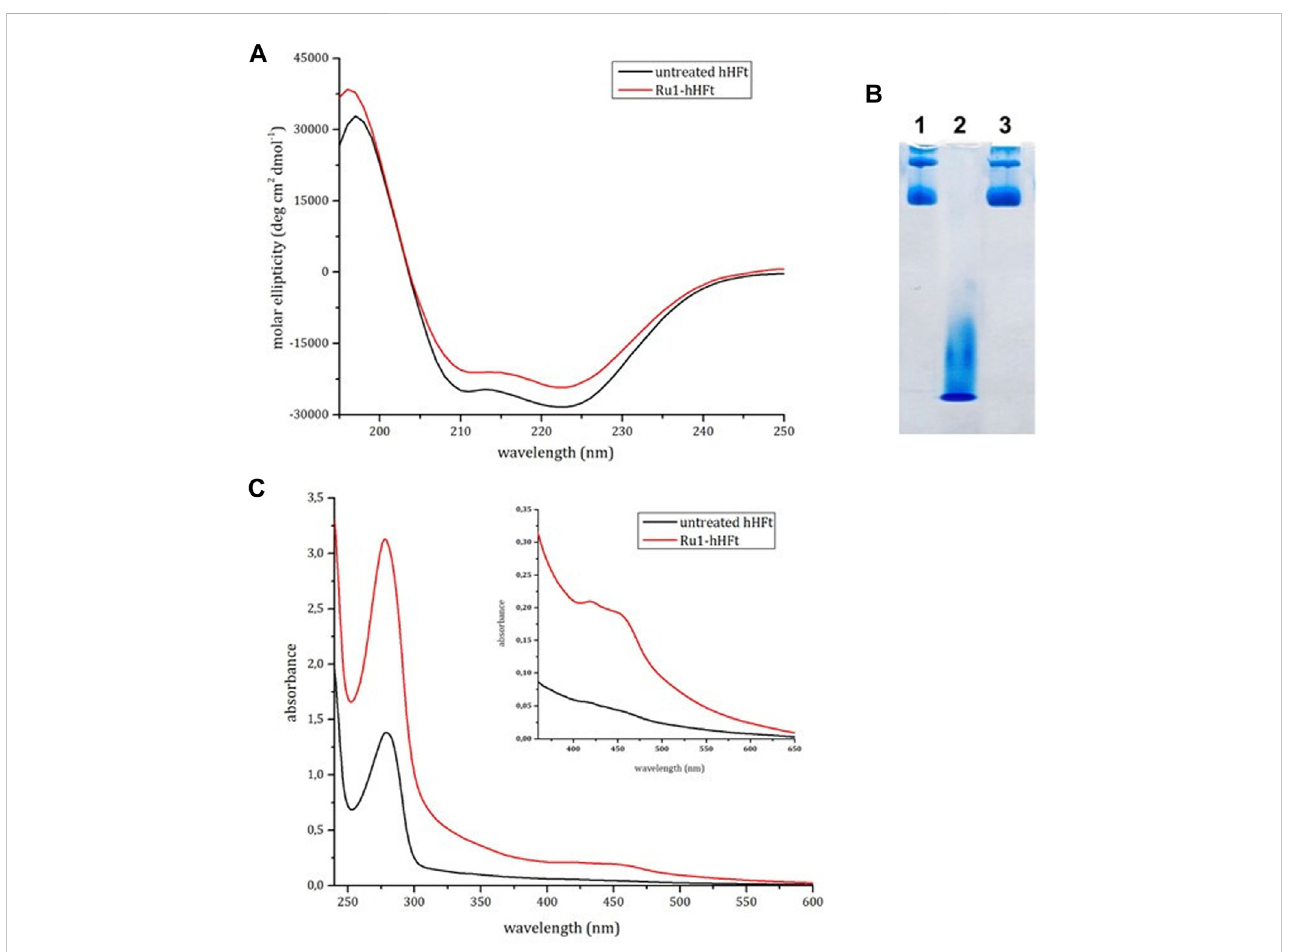
FIGURE 5 Electrophoretic and spectroscopic analysis of Ru1-hHFt. (A) CD spectra of reference hHFt (black line), and of Ru1-hHFt (red line). (B) electrophoresis under native conditions of hHFt, lane 1 reference hHFt, lane 2 disassembled hHFt incubated with 0.1% SDS, and lane 3 Ru1-hHFt after encapsulation. (C) UV- vis spectra of reference hHFt (black line), and of Ru1-hHFt (red line). All the spectra were acquired in 20 mM Tris-HCl pH